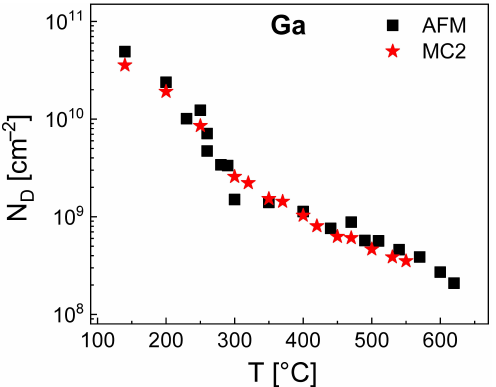
Figure 7. Comparison of experimental Ga droplet densities with simulation results obtained using the MC2 model with E S = 0.115 eV and a T -dependent E E (see